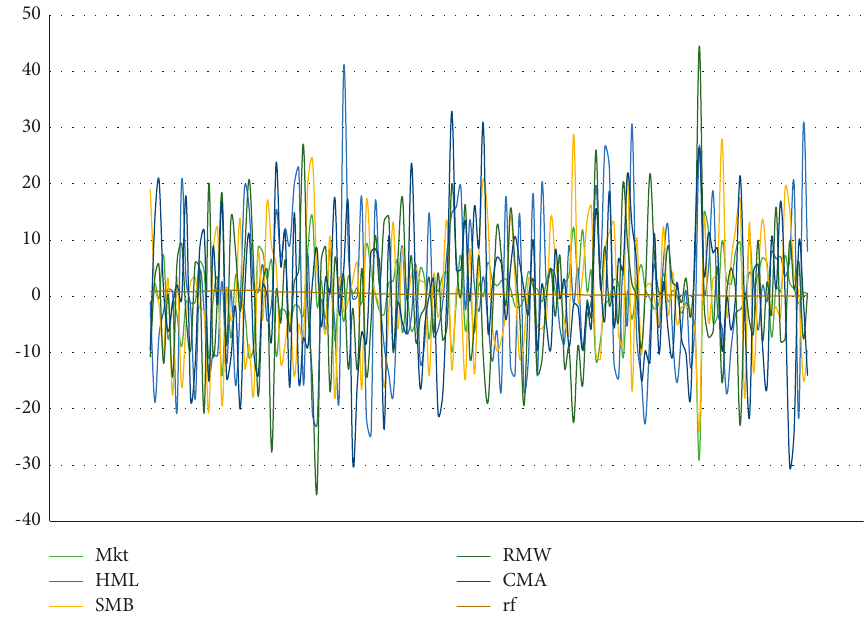
Figure 3: Movements of factors and risk-free rate over time. Table 3: Correlation between variables.